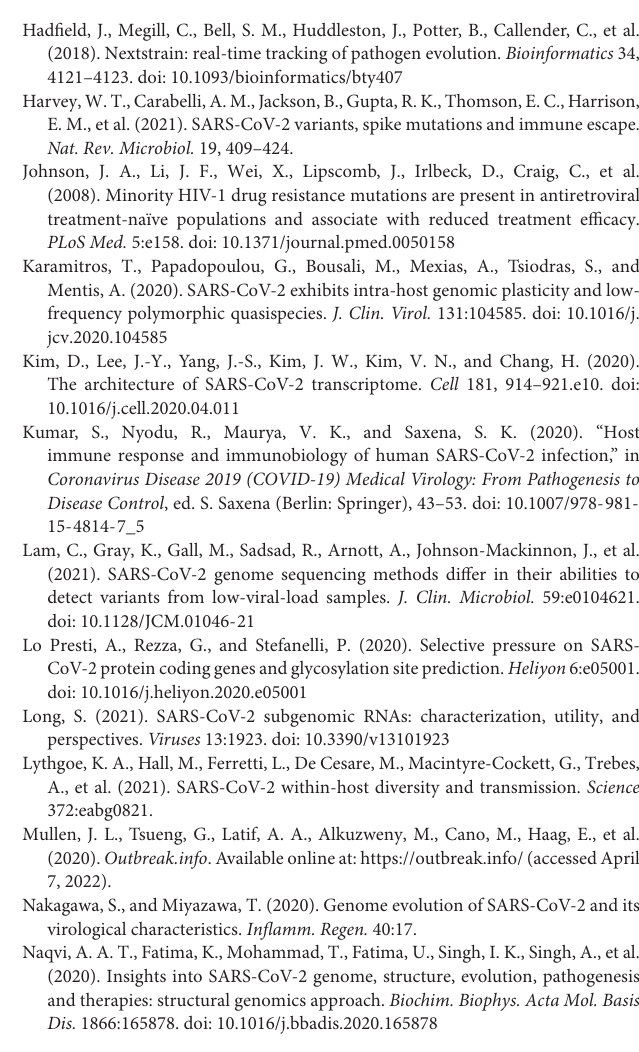
the interquartile range (25th to 75th percentile) is represented by the white shading, the whiskers represent the minimum and maximum values, and the outliers are shown by the black circles. Supplementary Figure 3 | Counts of SNPs (A) and iSNVs (B) by SARS-CoV-2 gene for the culture cohort. Frequencies ≥ 0.9 were considered SNPs. Problematic sites are not included. NC signifies non-coding region of the genome. Supplementary Figure 4 | Frequencies of SNPs (A) and iSNVs (B) by SARS-CoV-2 gene for culture cohort. Frequencies ≥ 0.9 were considered SNPs. Problematic sites are not included. NC signifies non-coding region of the genome. Supplementary Figure 5 | Violin plots depicting the sgRPTL normalized counts for sgRNA abundance at each gene from top to bottom of Culture A, Culture Beta, and Culture Delta. There was significantly higher sgRNA across all genes in Delta compared to A and Beta. A and Beta were not significantly different. Individually, N was significantly higher in Delta compared to Beta and ORF 7a and 8 were significantly high than both A and Beta. The boxplots within the violins indicate the median and the interquartile ranges (25th to 75th percentile). Supplementary Figure 6 | Median sgRPTL by SARS-CoV-2 gene from inoculum (day 0) to day 3 for culture dilutions (top) lineage A, (middle) Beta, and (bottom)